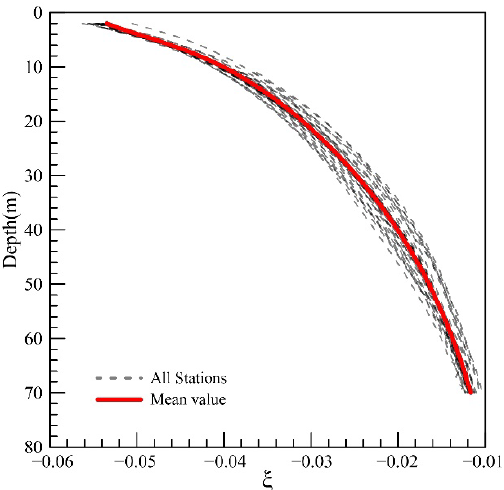
Figure 4. The 37 profiles and mean profile denoted by the red line for ε observed in the identical sites in Figure 3.